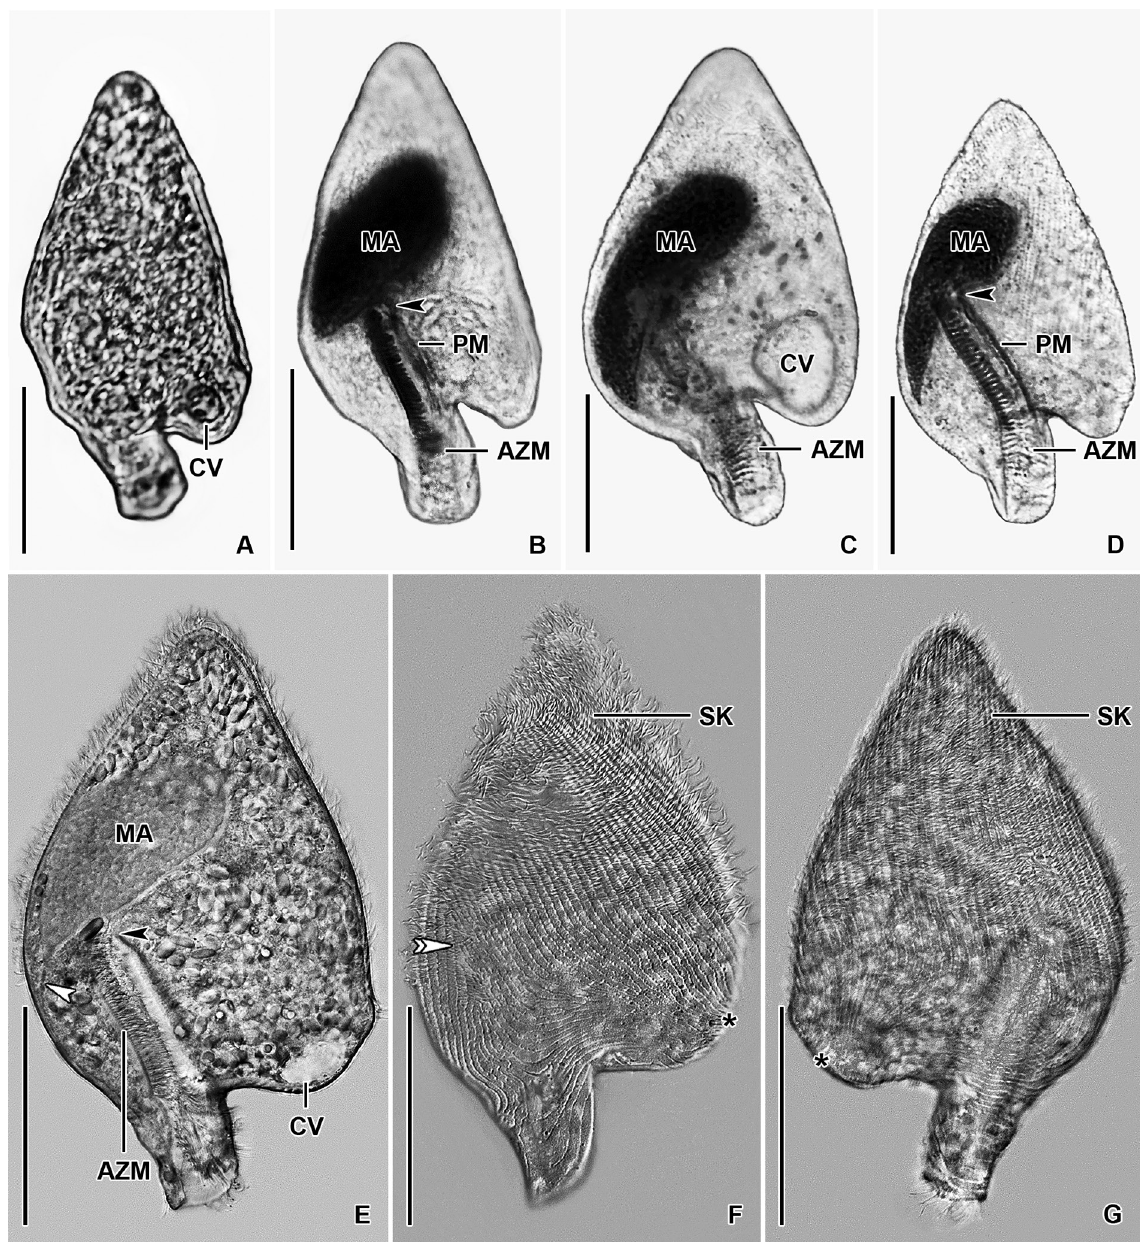
Fig. 11. Clevelandella parapanesthiae (Kidder, 1937). Vietnamese specimens (a–B, E–G) isolated from Panesthia angustipennis cognata Bey-Bienko, 1969 and Thai I specimens (C–D) isolated from Panesthia angustipennis angustipennis (Illiger, 1801) from life (a, E–G) and after protargol impregnation (B–D). A–D . Ventral views of specimens with well-preserved body shape. Black arrowheads mark the proximal end of the adoral zone of membranelles. E–G . A strongly squeezed specimen by pressure of the cover slip, causing the body to become markedly wider and the notch at the base of the peristomial projection to be lost. The general body organization is shown in (E), the ciliary pattern of ventral and dorsal sides is shown in (F) and (G). asterisks mark the position of the ciliary whorl (posterior suture), white arrowhead denotes the karyophore attaching to right body margin, white double arrowhead denotes the right suture. Scale bars = 30